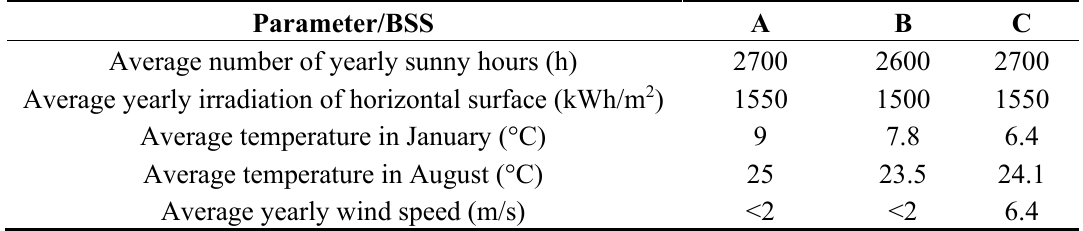
Table 2. Meteorological characteristics of analyzed BSSs